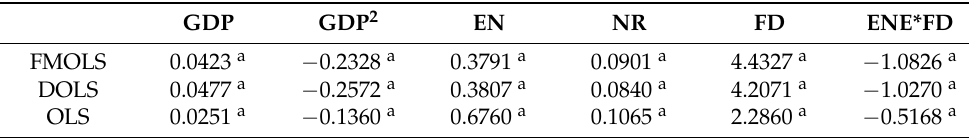
Table 5. Result of DOLS, FMOLS, and